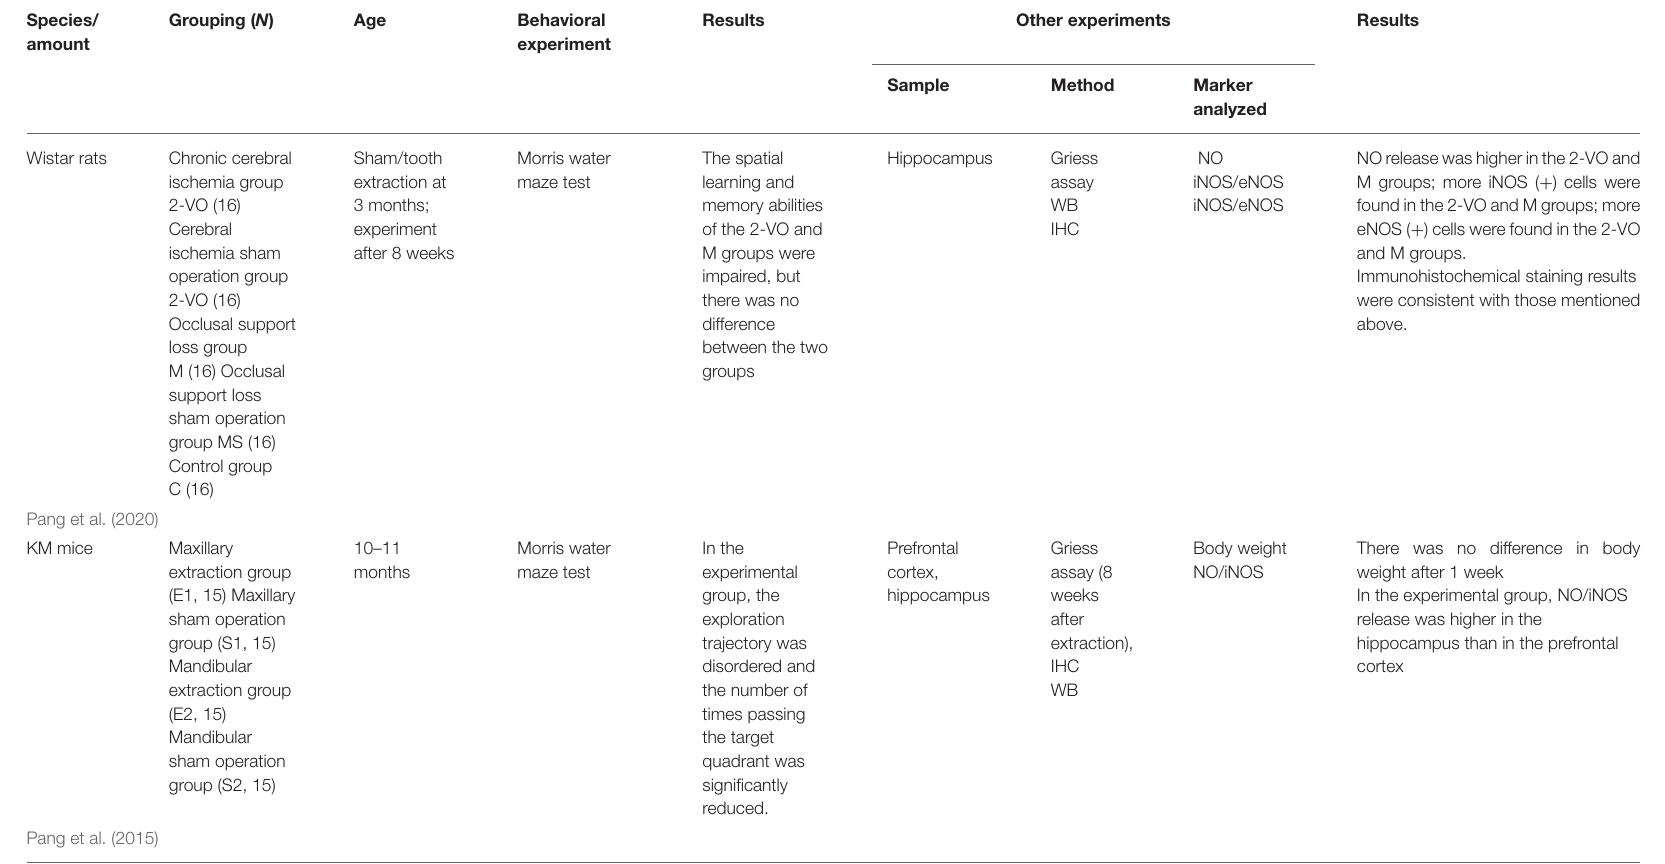
TABLE 5 | The inflammatory stress pathway. Species/ Grouping ( N ) Age Behavioral amount